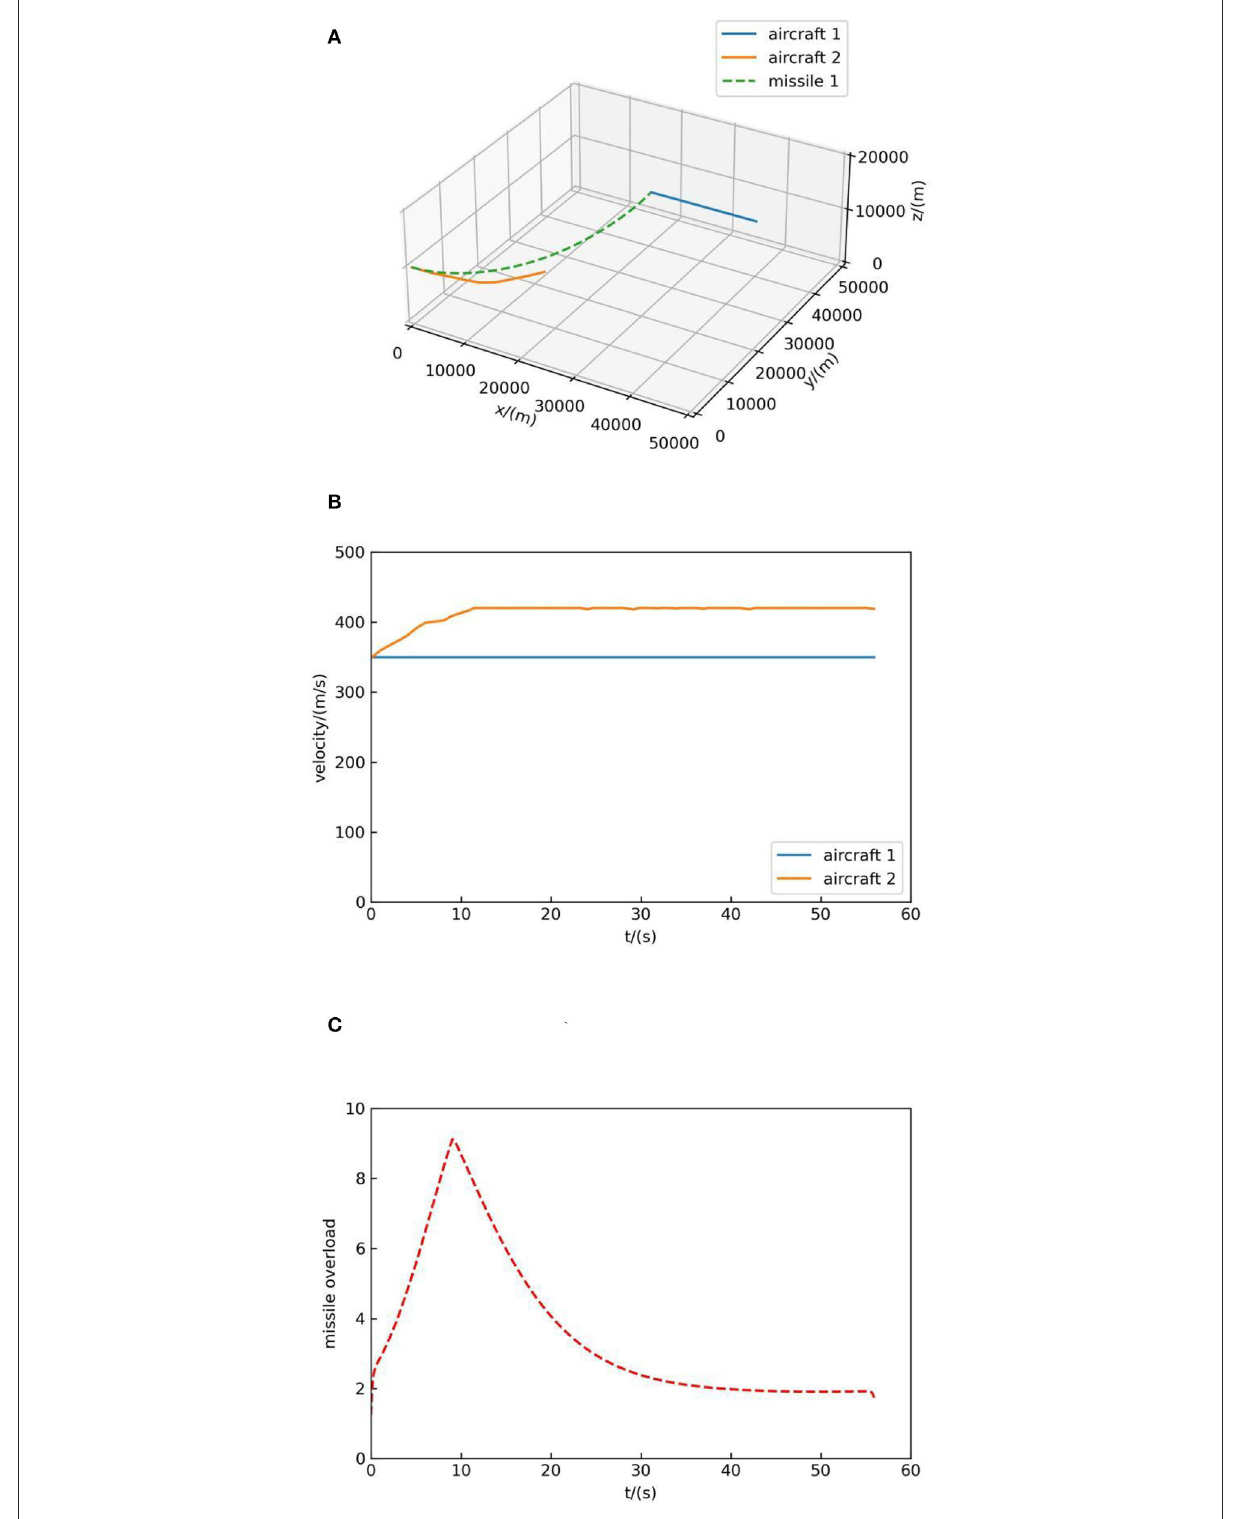
FIGURE7 Simulation result 1. (A) Air combat trajectory. (B) Velocity. (C) Missile